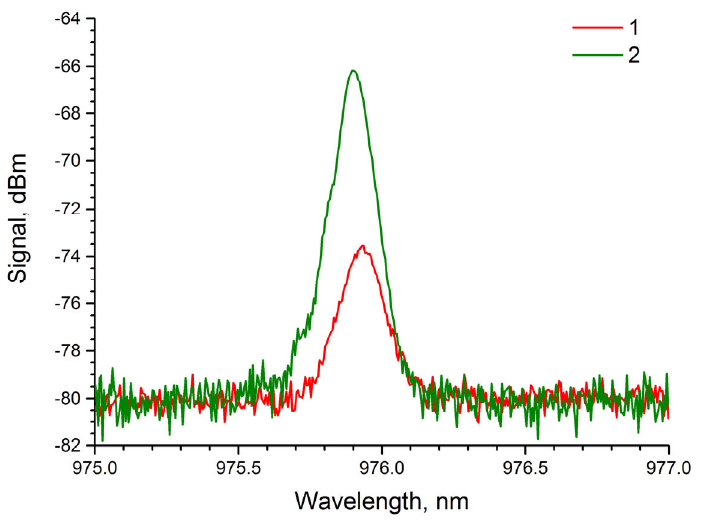
Figure 6. Reflection spectra of an array of low-reflecting FBGs of the “random” laser (“1”) and a single FBG of 10 mm long (“2”).